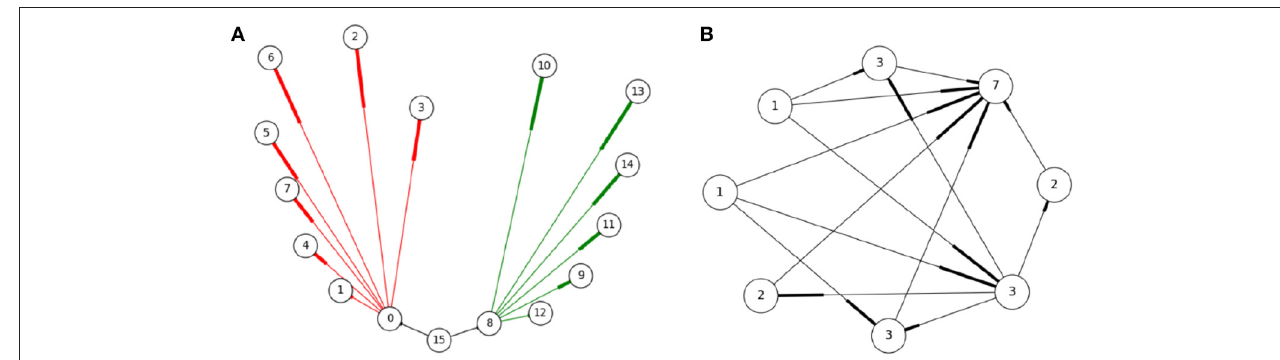
FIGURE 4 | Representing the SNN as a hypergraph (A) : Three hyperedges (black, red, and green) shown, where a hyperedge includes a pre-synaptic neuron and all its post-synaptic neurons (the numbers describe neuron IDs). This representation corresponds to the manner neurons communicate, i.e., when a neuron fires all its post-synaptic targets need to be notified. (B) The hypergraph nodes are weighed by the number of dendritic inputs to a neuron as an estimate of the workload located at each process. In this example, edges represent synaptic connections between neurons (nodes), with the thicker end indicating direction. The number on the node represents the weight associated to each neuron, equal to the sum of its input plus